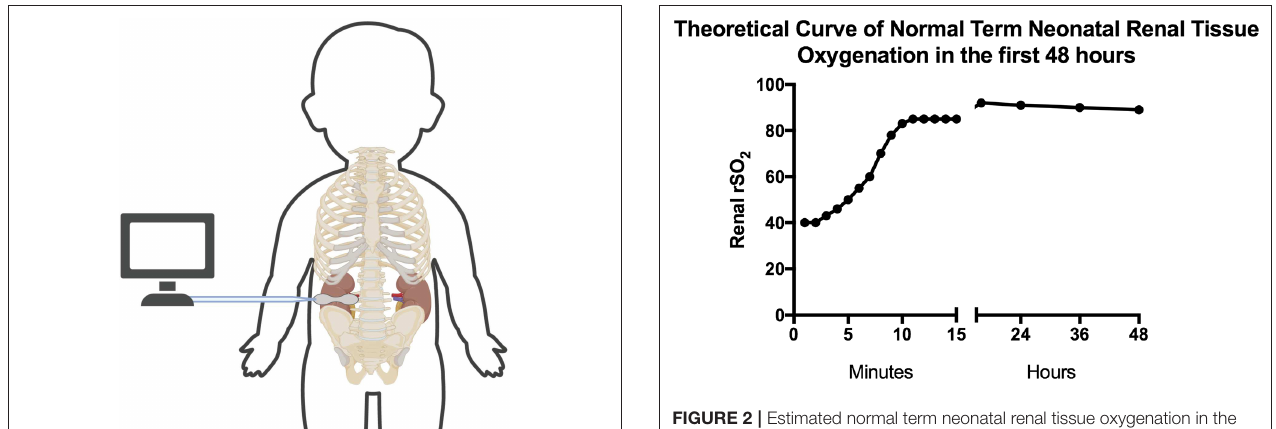
that have discussed how frequently artifact or loss of signal occurs with neonatal renal tissue oxygenation monitoring.